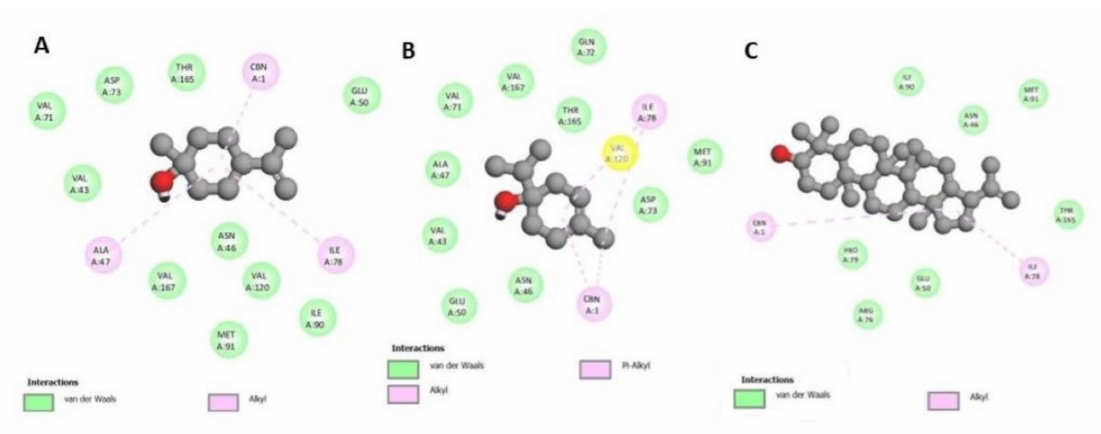
Figure 7. The interaction between DNA gyrase and tested compounds. ( A ):